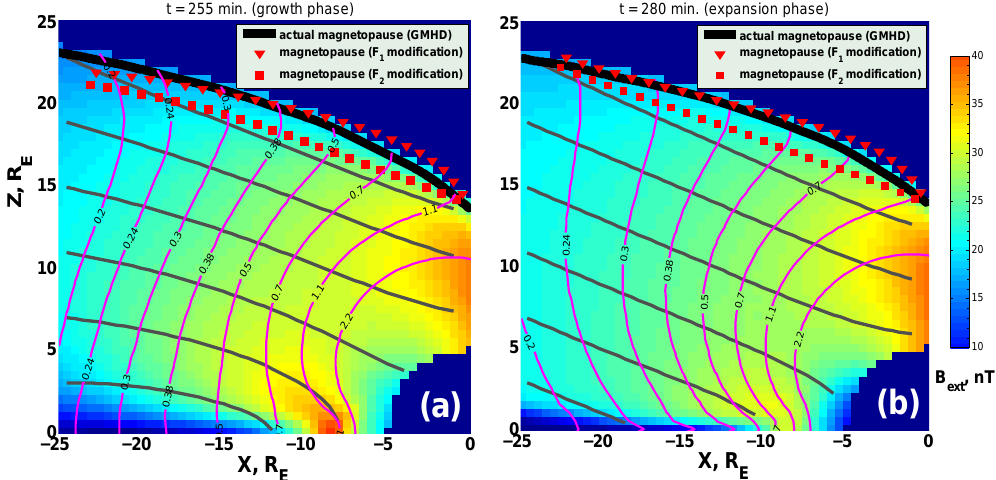
Figure 2. Results of the simulation BATSRUS_Gordeev_110309_1 in the meridional magnetosphere cross section y = 0 for two simulation moments: (a) 255min and (b) 280min correspondingly. Black lines are the B ext field lines; B ext values are shown by color. Total pressure (in nPa) isolines (magenta) are also shown. The solid black line indicates the reference magnetopause (fluopause), whereas the red triangles and red squares designate the R T and R T ext position.